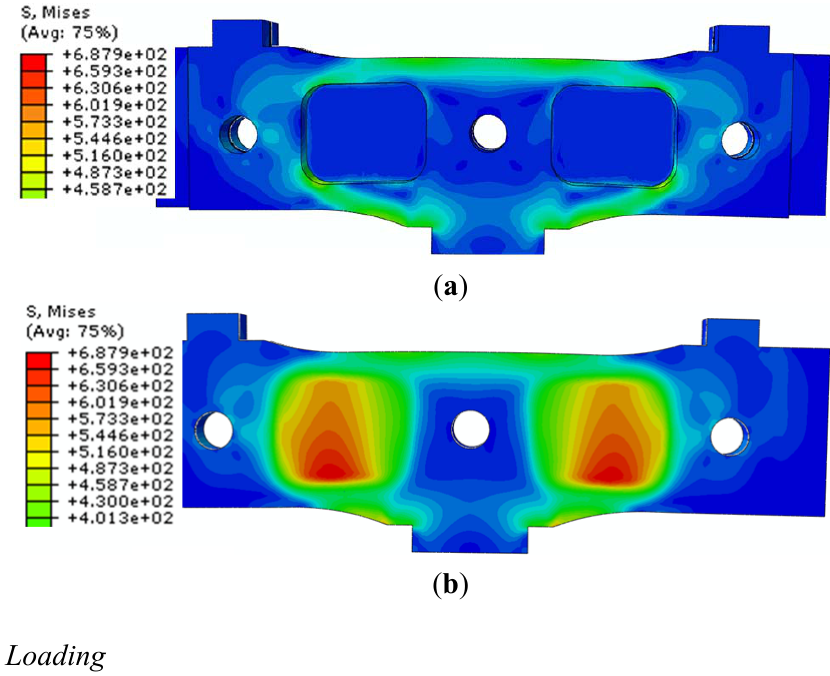
Figure 5. State of von Mises stresses for symmetric loading ( σ ( a ) Assembled sensor module; ( b ) Central elastic plate.